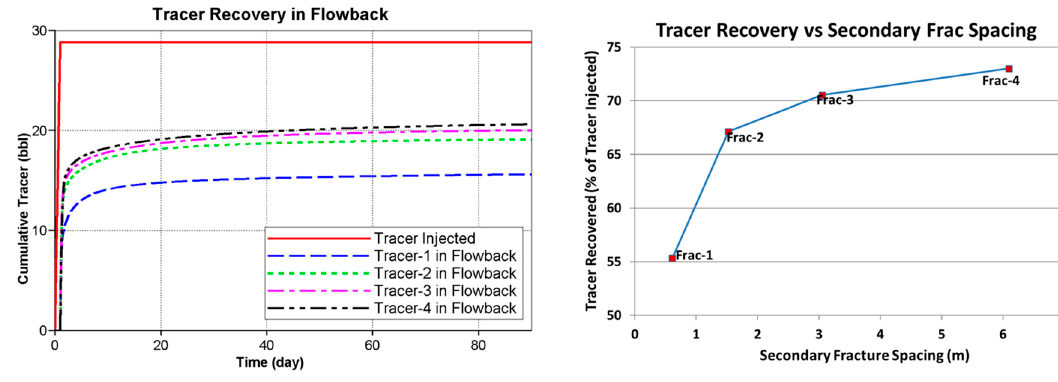
Figure 15. E ff ect of fracture complexity on tracer Figure 15. Effect of fracture complexity on tracer recovery.